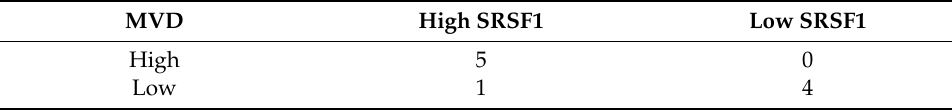
Table 2. Distribution of MVD scores according to SRSF1